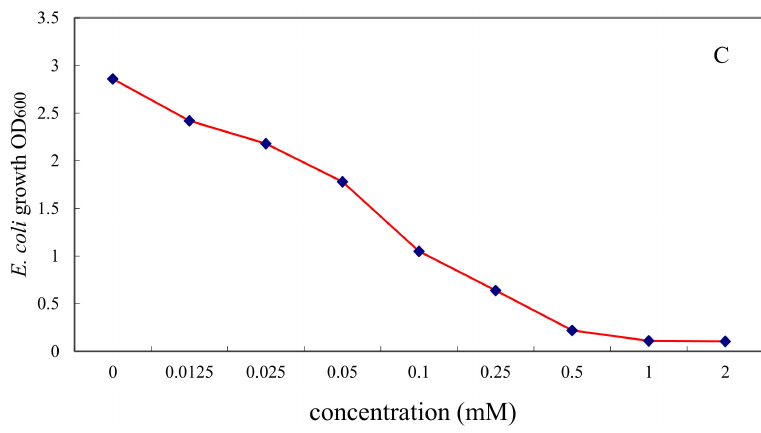
Figure 6. Inhibitory effects of L -cyclopropylalanine against S. cererisiae ( A ); C. albicans ( B ) and E. coli ( C